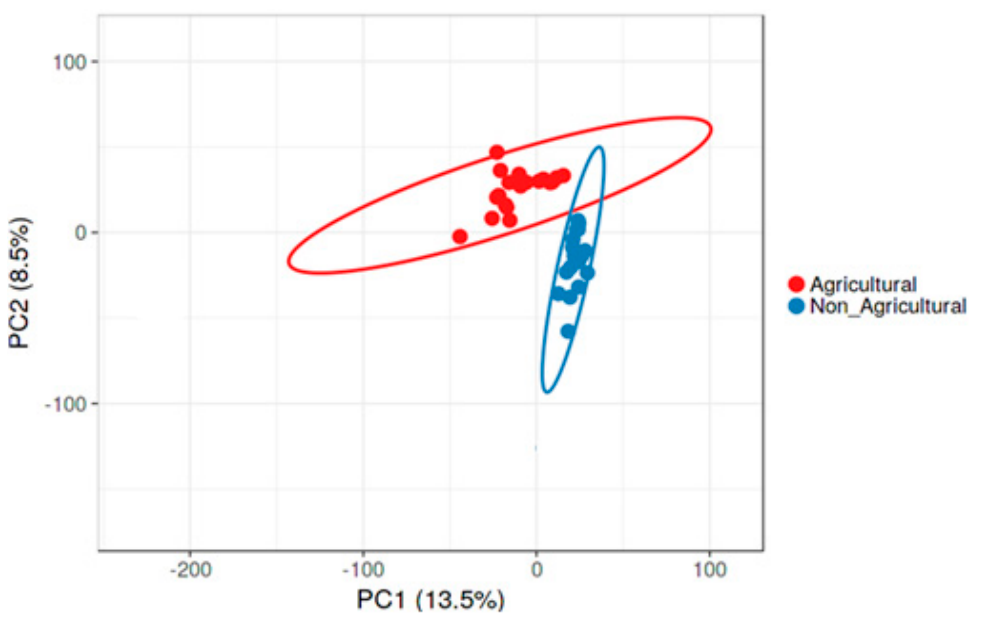
Figure 4. A principal component analysis (PCA) plot showing differences in structure of bacterial communities between agricultural (red circles) and non-agricultural (blue circles) soil at phylum level. Unit variance scaling is applied to rows; Singular value decomposition (SVD) with imputation was used to calculate principal components. X and Y axes show Principal Component 1 and Principal Component 2 that explain 13.5% and 8.5% of the total variance, respectively. Prediction ellipses are such that with a 0.95 probability, a new observation from the same group will fall inside the ellipse. N = 40 data points.